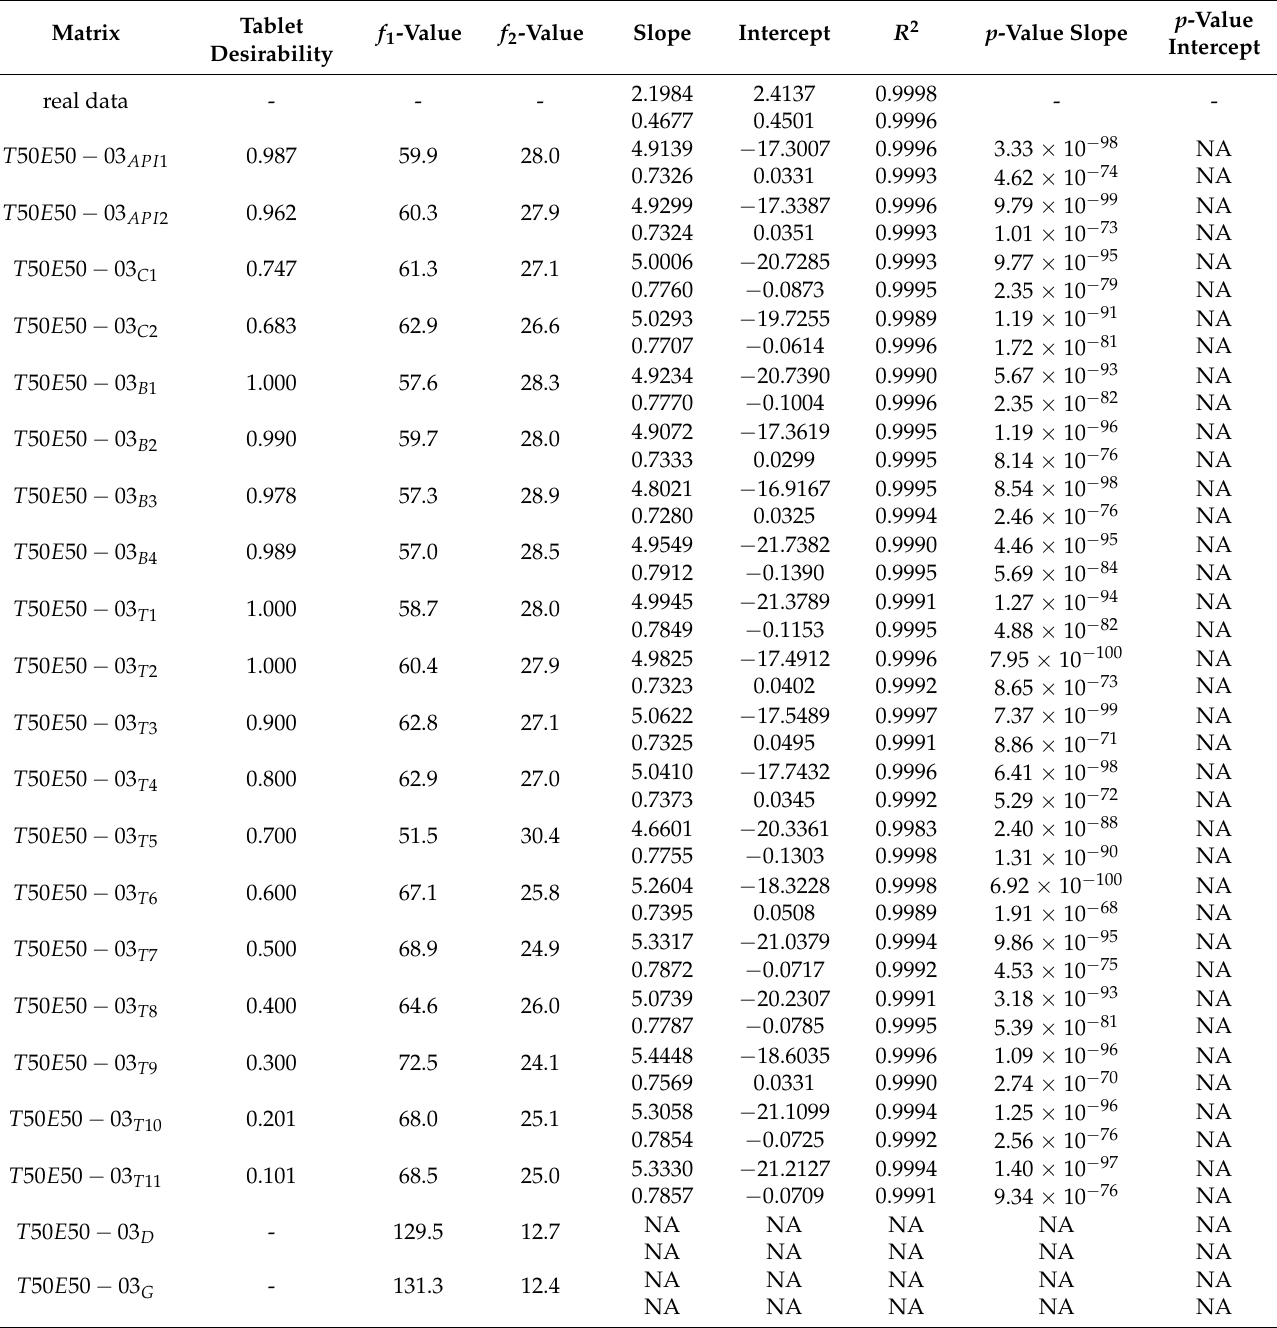
Table A4. The calculated results of the comparison of the predicted dissolution profiles and the experimental one. The first row in a cell is the value of the Higuchi plot, the second row represents the value of the Korsmeyers–Peppas plot. ’NA’ indicates that a value was not calculated because either there were too few data points or it was not necessary, e.g., if the slopes were significantly different, the p -value of the axis intercept was not